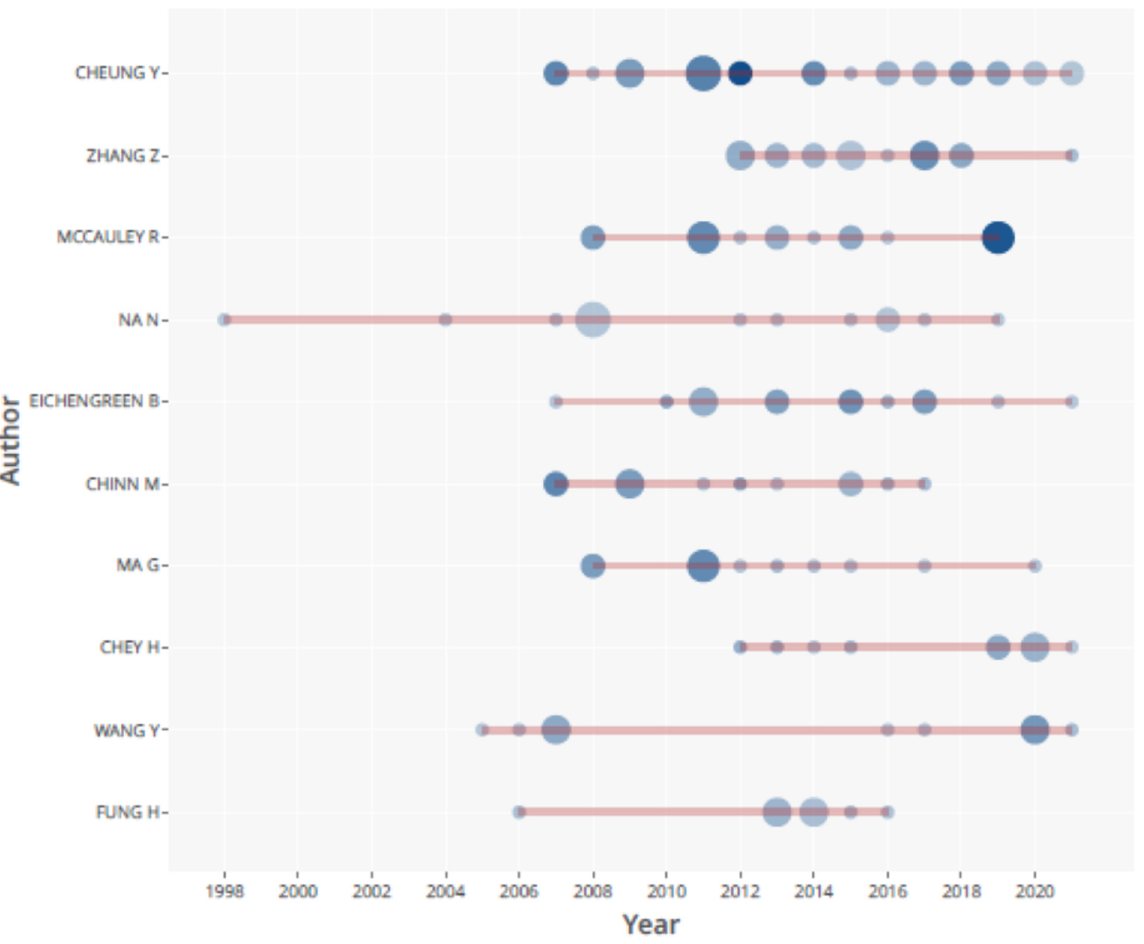
Figure 3. Top 10 authors’ production over time. The bigger the circle is, the more articles have been published by the author in that year. The darker the circle is, the more citations per year have been acquired. Source: Authors’ elaboration using Biblioshiny.